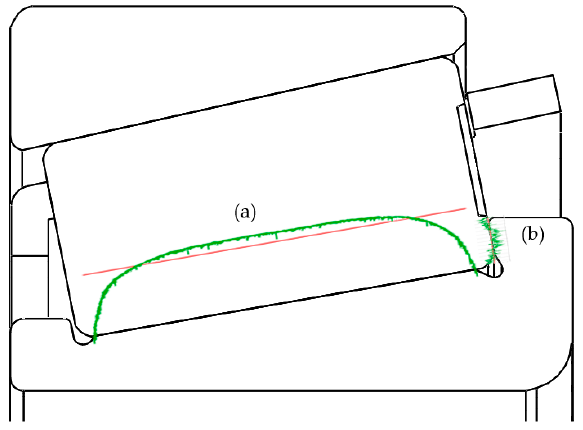
Figure 2. Measured profiles: ( a ) inner ring raceway profile; ( b ) flange profile.